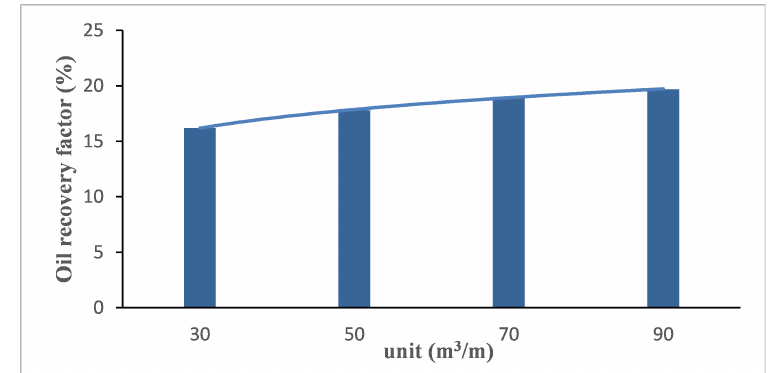
Figure 15. The huff-n-puff oil recoveries under different solvent slug